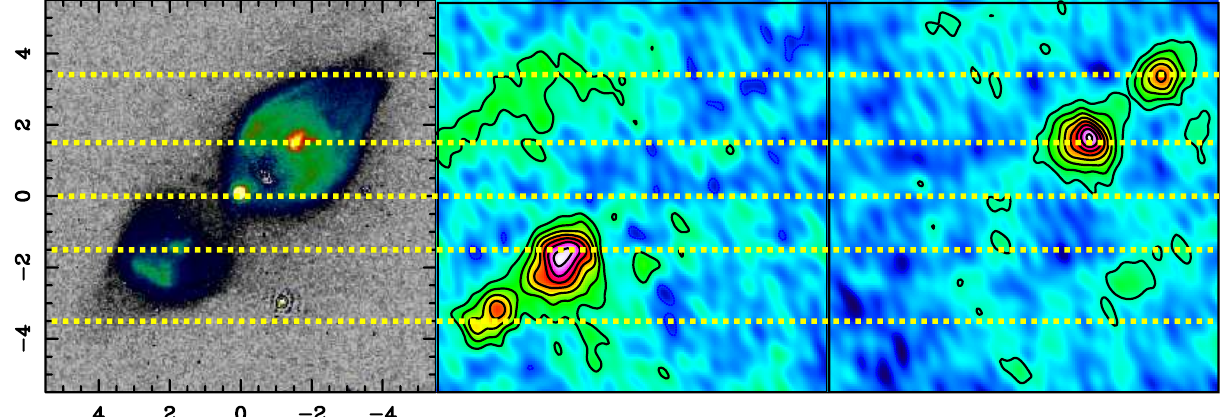
Figure 4. HST-WFPC2 [SII] emission image of M1–92 ( left ) from Bujarrabal et al. [7] and NOEMA HCO + J = 2–1 emission images for projected expansion velocity ranges +30 to +55kms − 1 ( centre ) and –55 to –30kms − 1 ( right ). We can see that the high-velocity HCO + arises from both the polar tips and the HH-like knots located in the middle of the two lobes. Contours in the centre and right panels are spaced every 8.3Kkms − 1